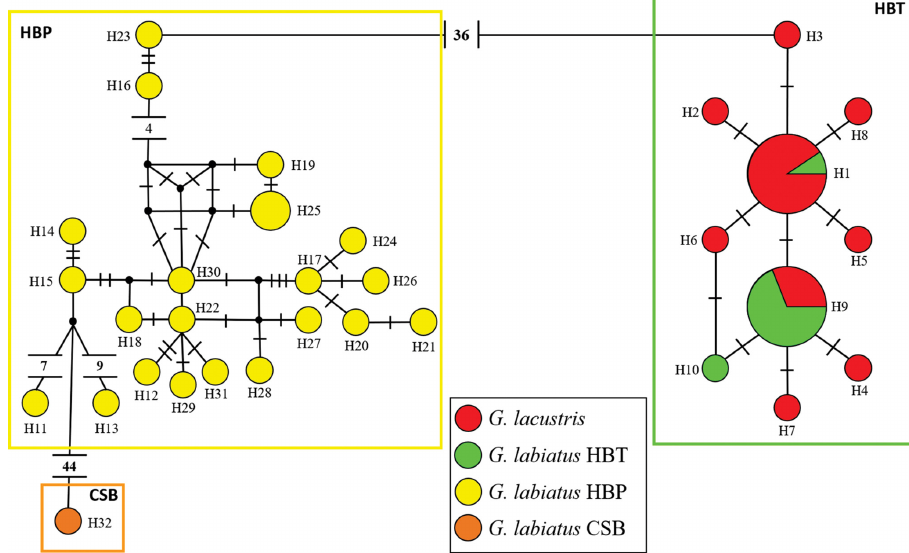
FIGURE 3 | Network of mitochondrial haplotypes of Gymnogeophagus considering the concatenated D-loop and CytB regions. The size of the circles is proportional to the number of individuals present in each haplotype. The colors represent the analyzed populations, according to the legend. Small circles represent medium vectors, and the number of traits or values associated with each branch corresponds to the mutational distance between haplotypes.